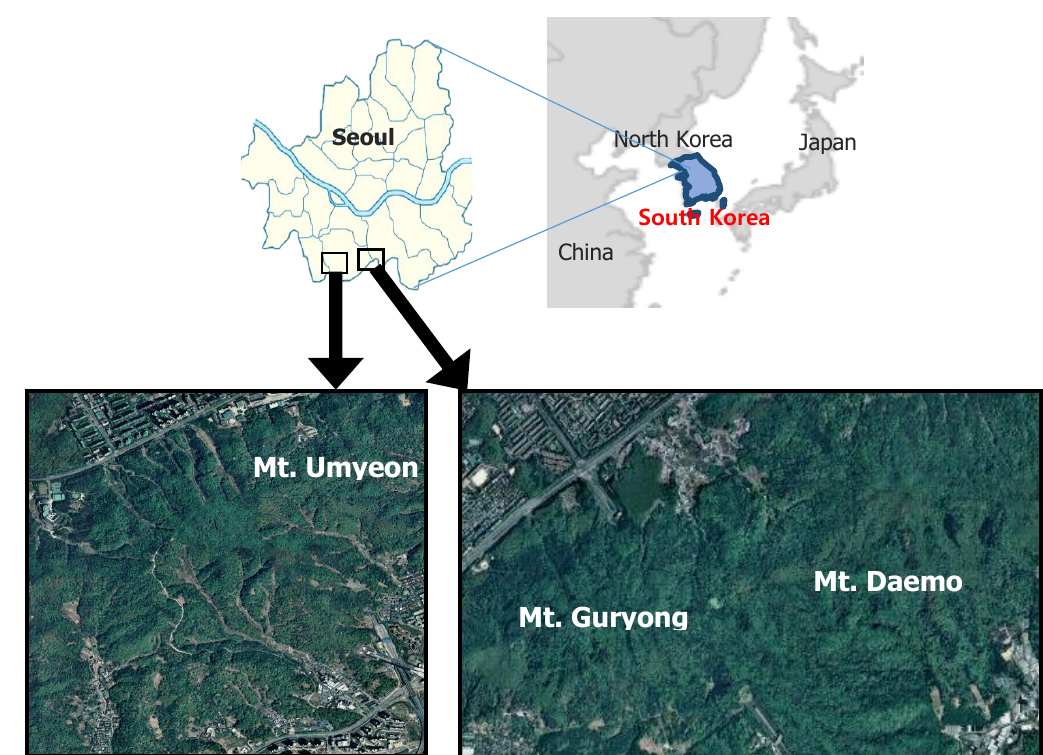
Figure 1. Location map showing the corresponding study area sample locations.